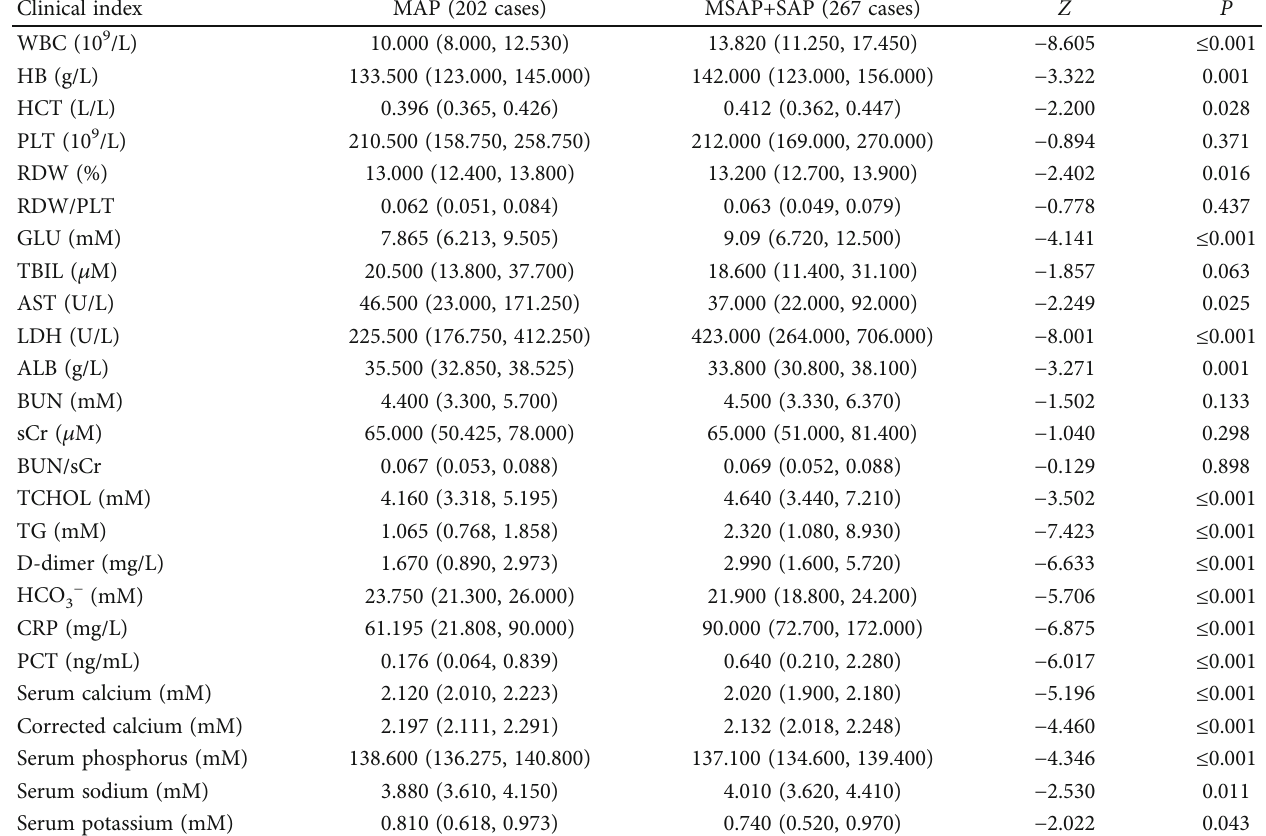
Table 2: Comparison of clinical indexes between the MAP and MSAP+SAP